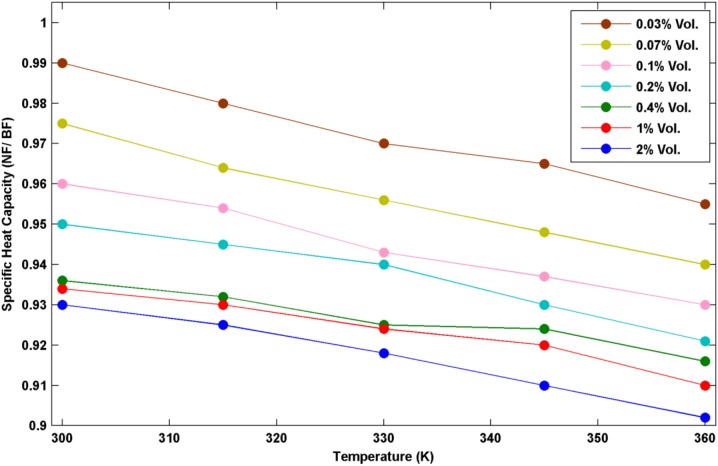
Cpnf/ Cpbf in different temperatures.